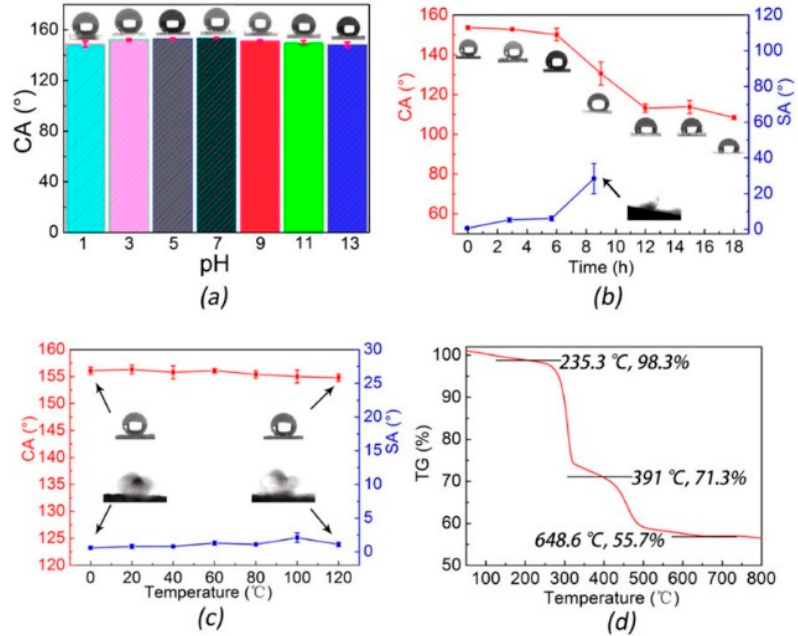
Figure 2. ( a ) Column chart of CAs of acidic and basic aqueous solutions with pH values from 1 to 13 on coated glass slides. ( b ) Broken line graph of the CAs and SAs of coated glass slide sample after 0 to 18 h of strong UV ‐ light exposure. Inset: corresponding optical images of CA and SA. Inset: optical images of CA and SA of the 0 and 120 °C samples. ( c ) Broken line graph of the CAs and SAs of coated glass slide sample stored in different temperatures from 0 to 120 °C for 2h. ( d ) The TG of STA–MH powders to 800 °C. Reprinted with permission from [35], 2006, ACS Publications.